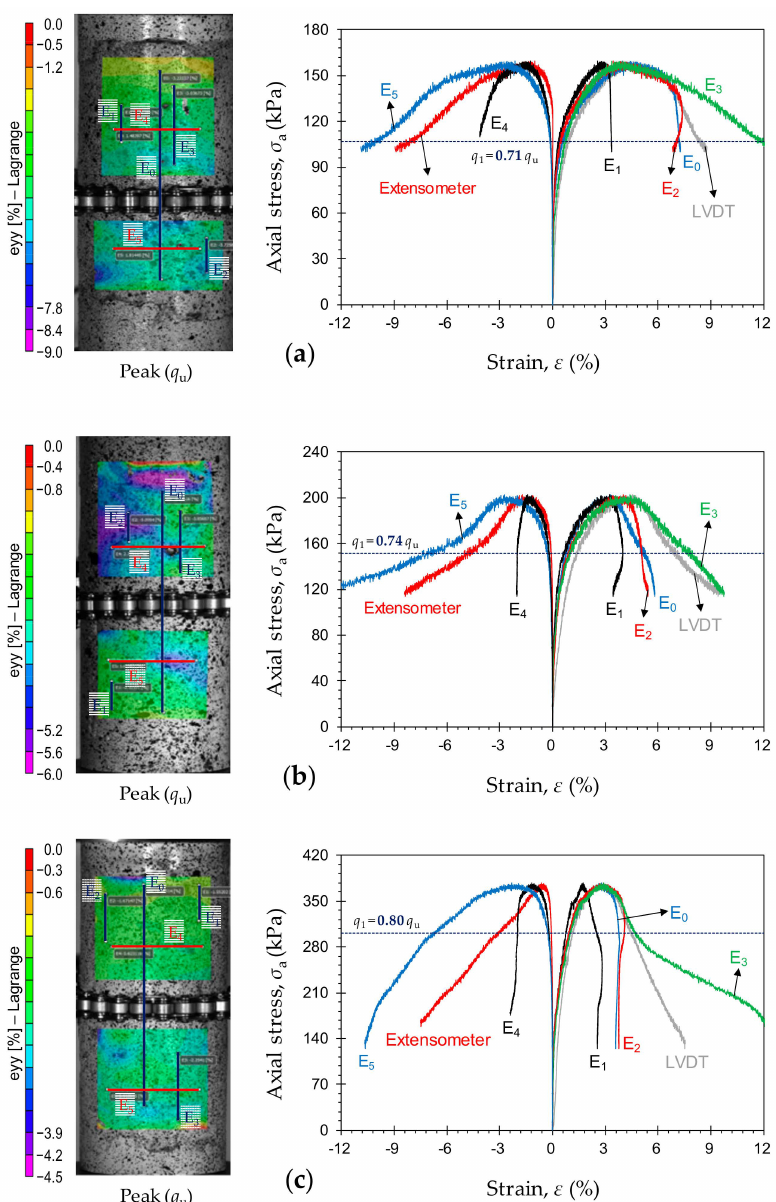
Figure 10. Typical stress–strain curves, obtained by means of various measurement techniques, for the tested samples: ( a ) P 2 F 0 T 14 ; ( b ) P 3 F 0 T 14 ; and ( c ) P 5 F 0 T 14 . Typical stress–strain curves, obtained by means of various measurement techniques, for the samples P 4 F 1 T 14 , P 4 F 2 T 14 and P 4 F 3 T 14 are provided in Figure 11a–c, respectively. Unlike curing time and PC content, FA content did not significantly alter the localization behavior. At any given curing time, and for any given PC content, the axial stress level required to initiate localization (or q 1 ) was found to be rather independent of the FA content. For instance, as demonstrated in Figure 11, the axial stress level required to initiate localization for the samples P 4 F 1 T 14 , P 4 F 2 T 14 and P 4 F 3 T 14 can be, respectively, calculated as q 1 = 0.78 q u , 0.77 q u and 0.78 q u ; these values are nearly equal to that obtained for the same 4% PC cured for 14 days containing no FA (i.e., P 4 F 0 T 14 with q 1 = 0.76 q u , as outlined in Figure